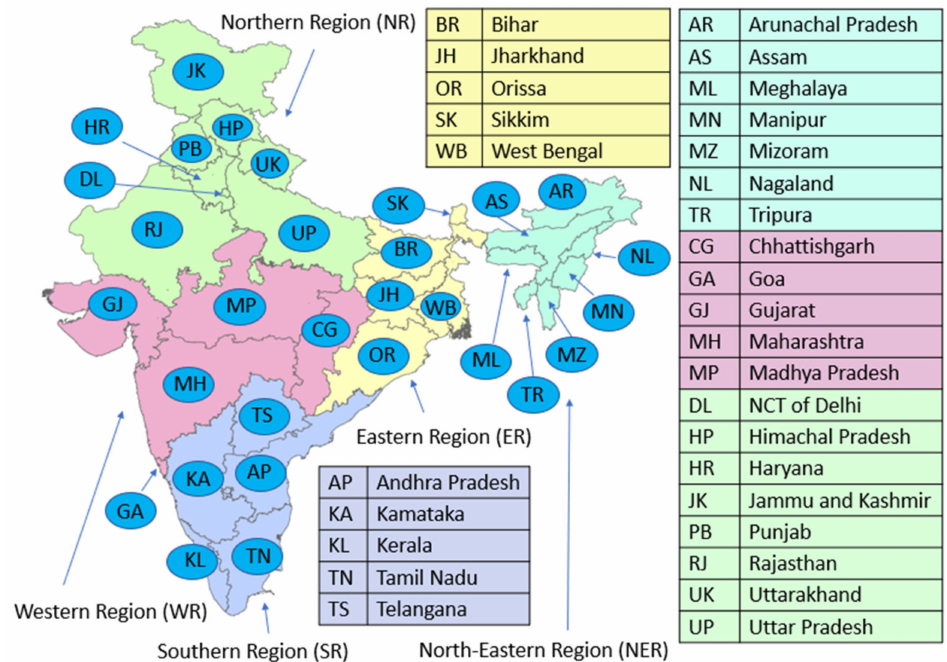
Figure 2. Diagram of the electricity grid of India, which consists of 5 regions and 30 states (shown as blue circles along with their